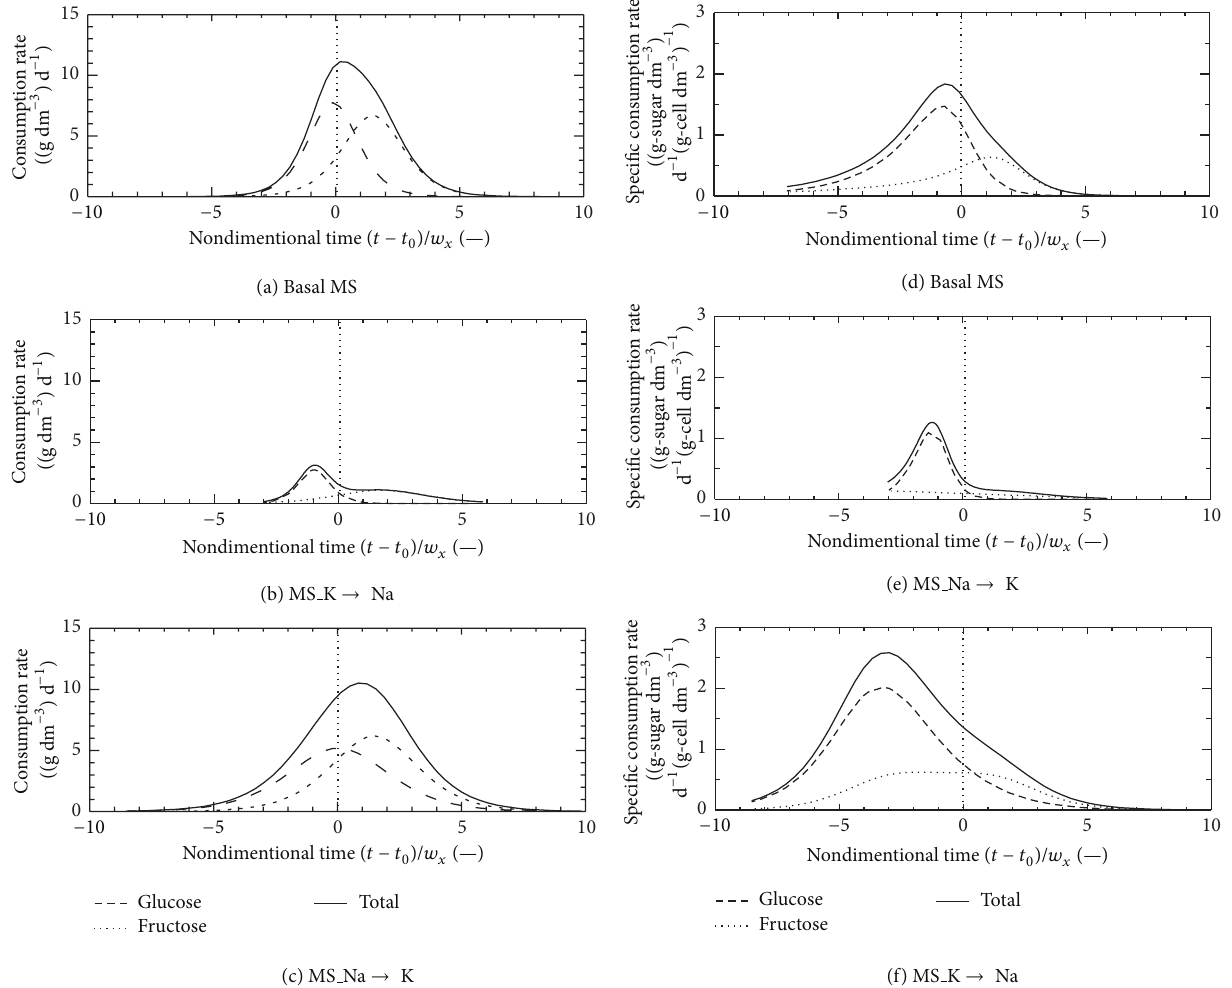
Figure 6: Time behavior of nondimensional time of consumption and specific consumption rates of glucose, fructose, and total sugar in cultivations using basal MS ((a), (d)), MS K → Na ((b), (e)), and MS Na → K ((c), (f))